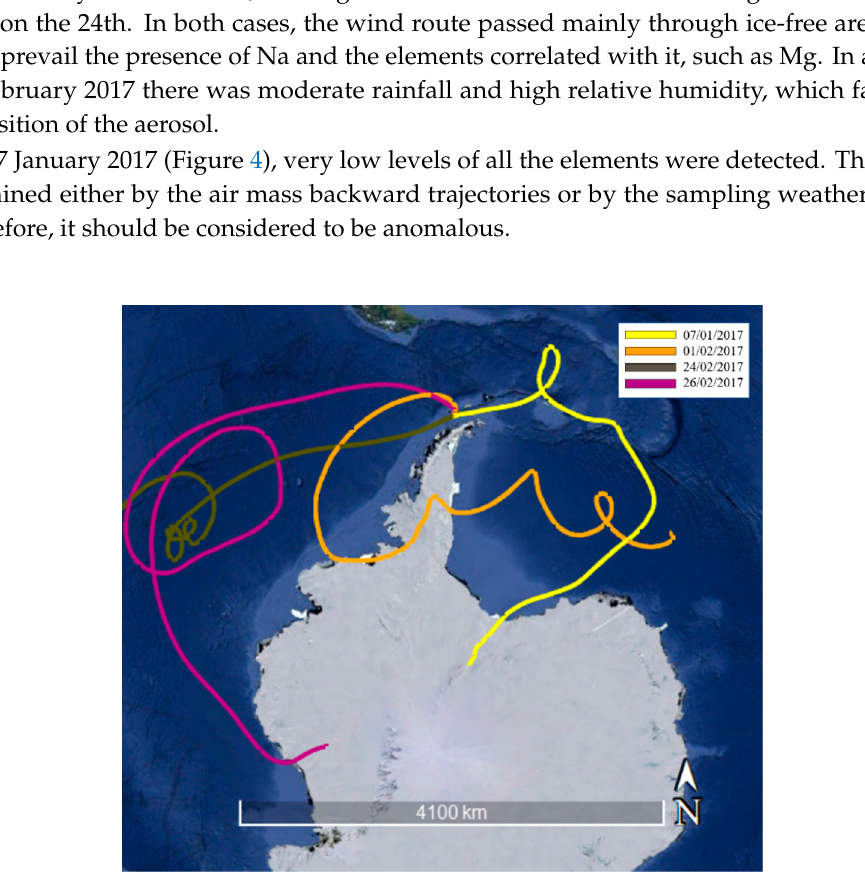
Figure 4. Total 10-day air mass backward trajectories at Gabriel de Castilla Station using GDAS1 (Global data assimilation system) dataset.